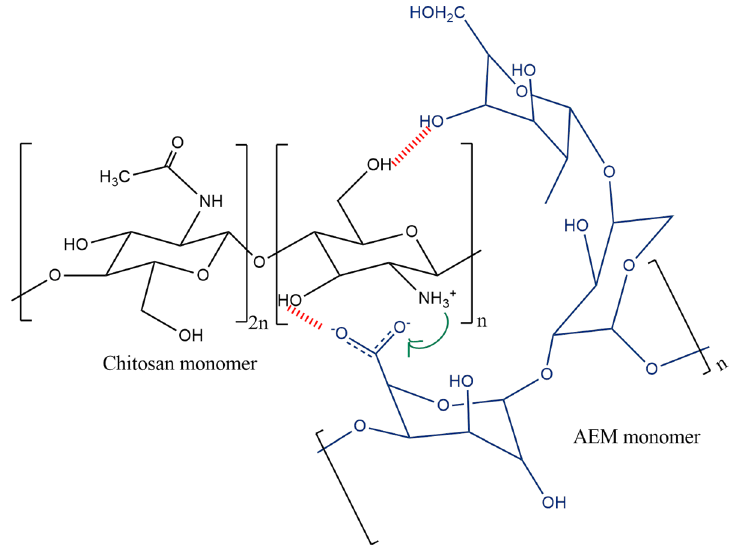
Figure 1. Electrostatic Interaction between AEM and CS monomers.